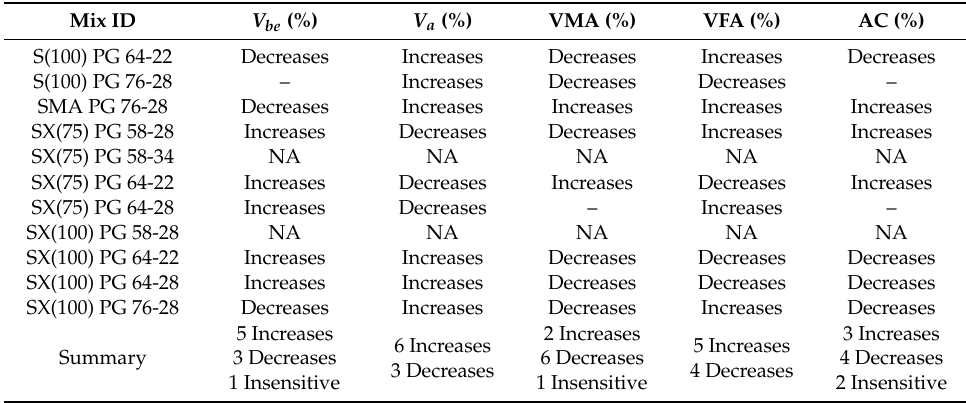
Table 4. Summary of the mix factors on the dynamic modulus of hot-mix asphalt